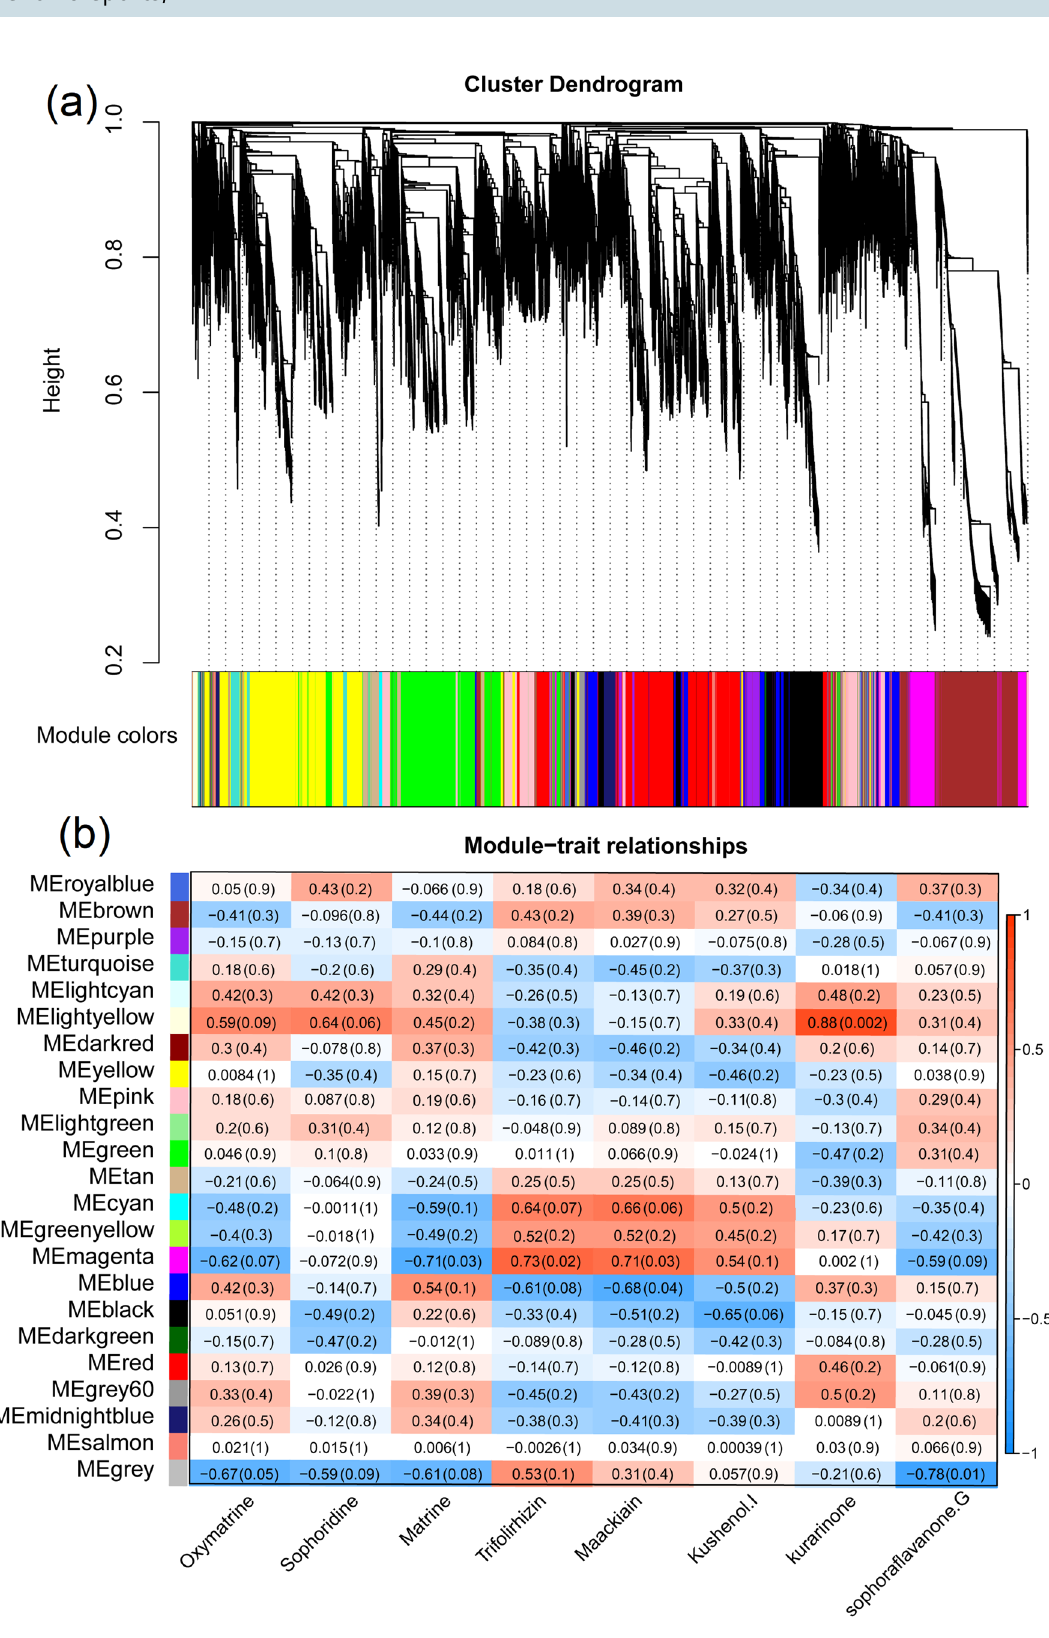
Figure 4. Co-expression profiles of all transcripts and active components in the root tissues of S. flavescens . ( a ) Hierarchical cluster tree showing co-expression modules in S. flavescens . ( b ) Module-components association in S. flavescens